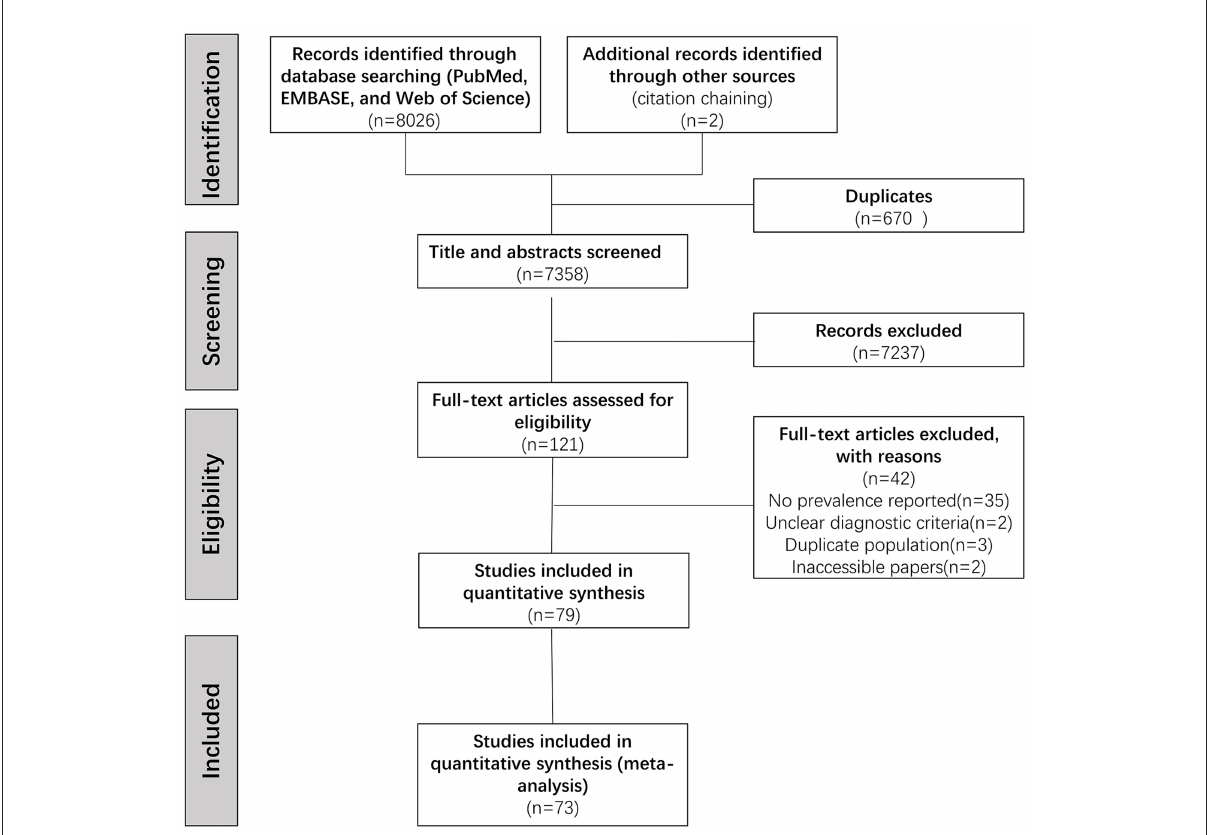
FIGURE1 Study selection flowchart, performed according to the PRISMA 2020 guidelines.